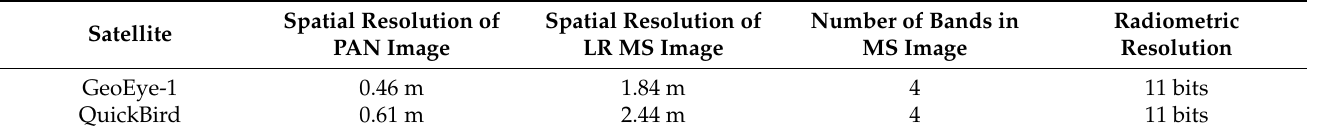
Table 1. Details of datasets from GeoEye-1 and QuickBird